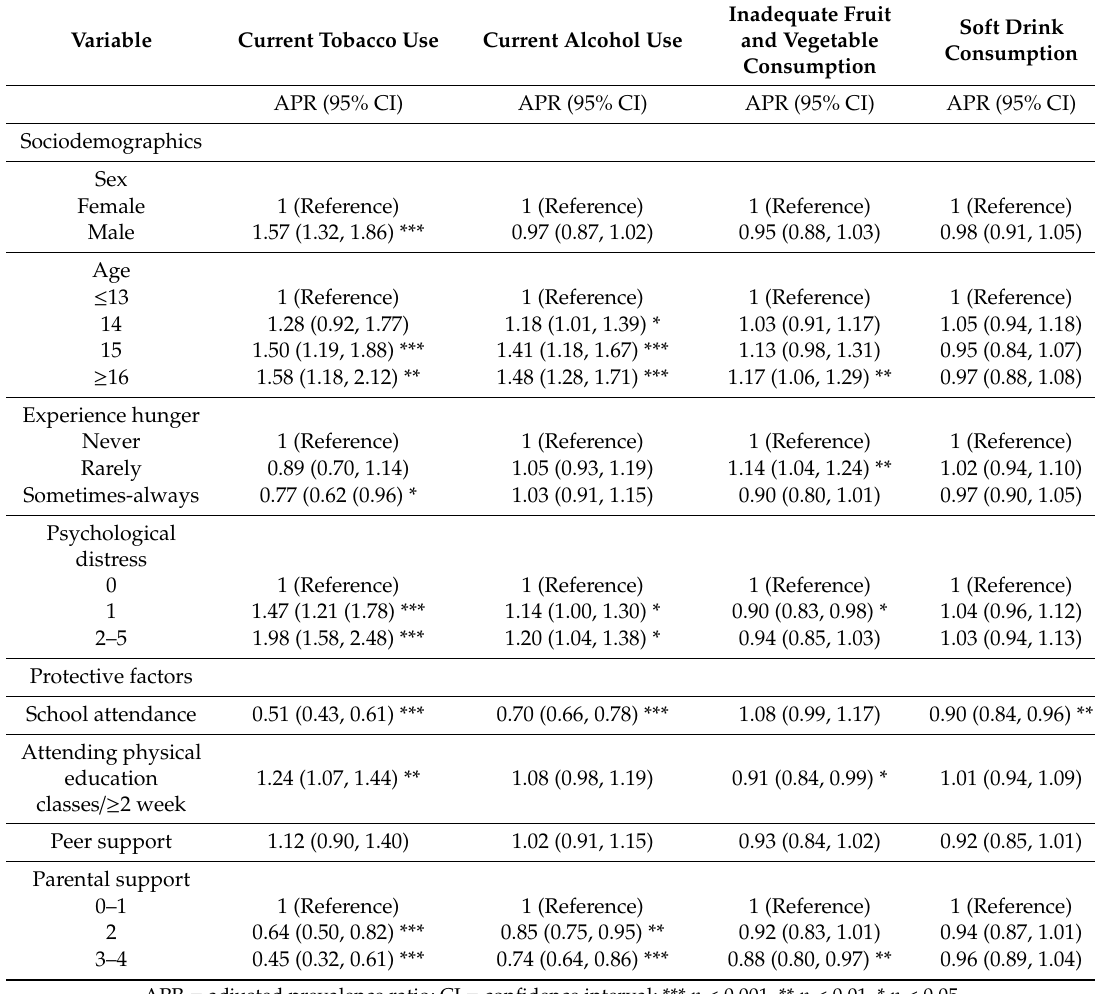
Table 2. Associations with behavioral non-communicable disease (NCD) risk factors (tobacco, alcohol, fruit and vegetable consumption, and soft drink consumption).